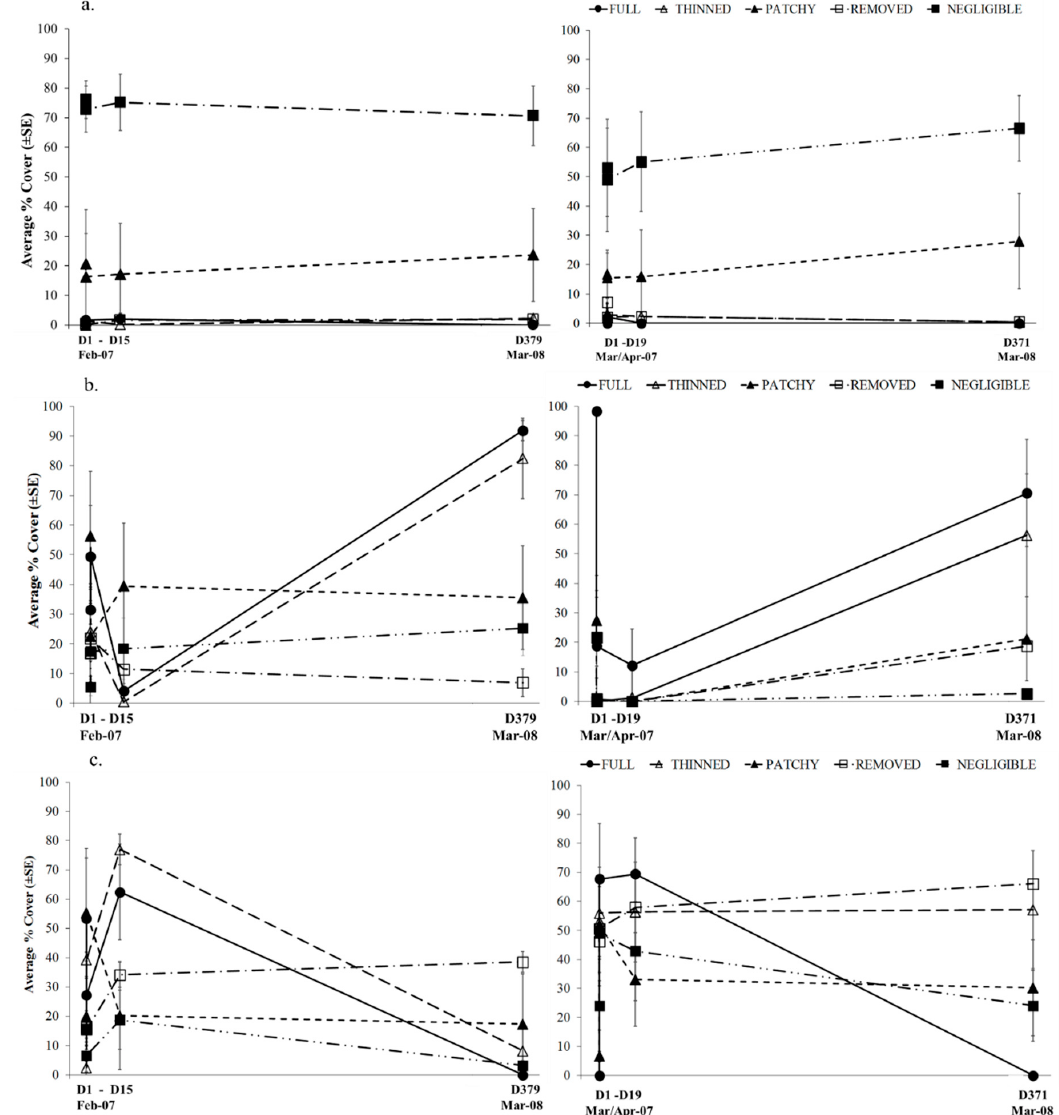
Figure 5. Average ± SE percentage cover of ( a ) C. implexa and X. pulex , ( b ) sand ( c ) bare rock for each treatment over time since manipulation of the canopy. 13th Beach on left hand side of panel, Bridgewater Bay on right hand side. N = 5 for all treatments.